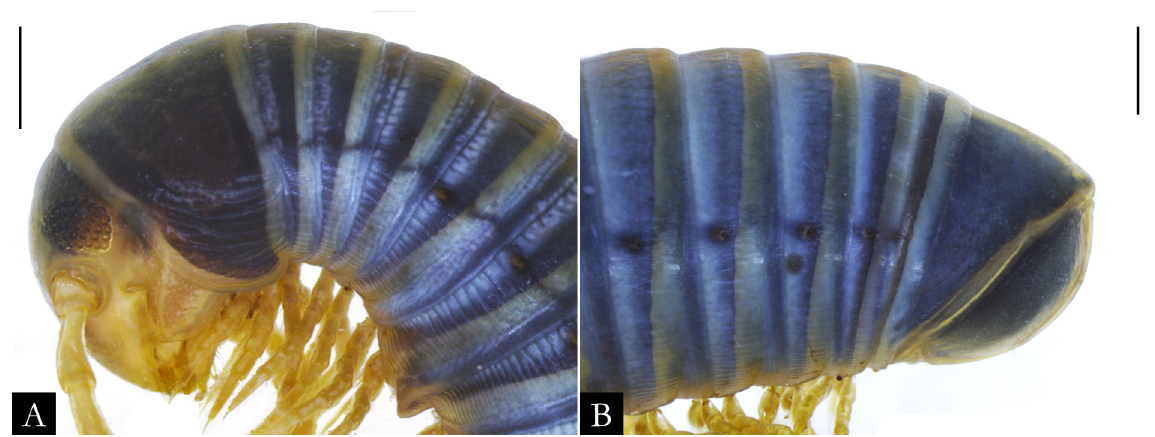
Fig. 83. Pseudonannolene longicornis (Porat, 1888), ♂ (IBSP 3734), in lateral view. A . Anterior region. B . Posterior region. Scale bars = 1